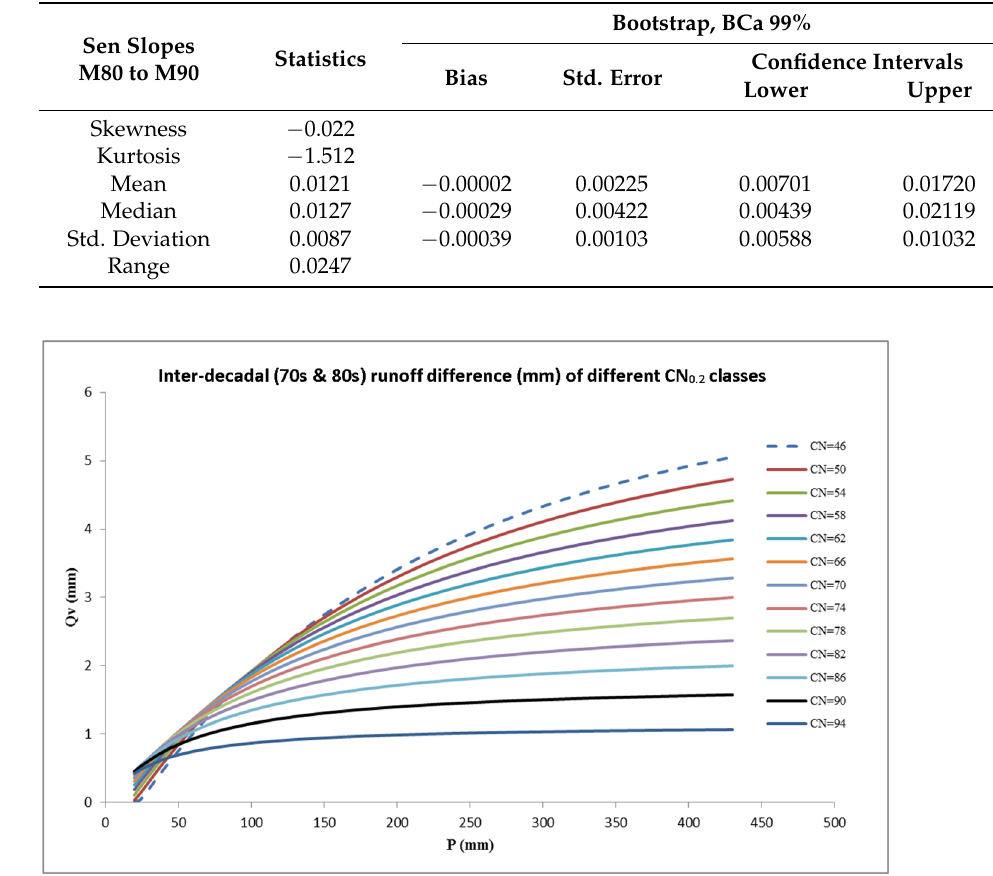
Figure 1. Decadal runoff difference of Equations (9) and (10) for selected CN 0.2 values to reflect the runo ff change between M70 and M80 under di ff erent rainfall depths.